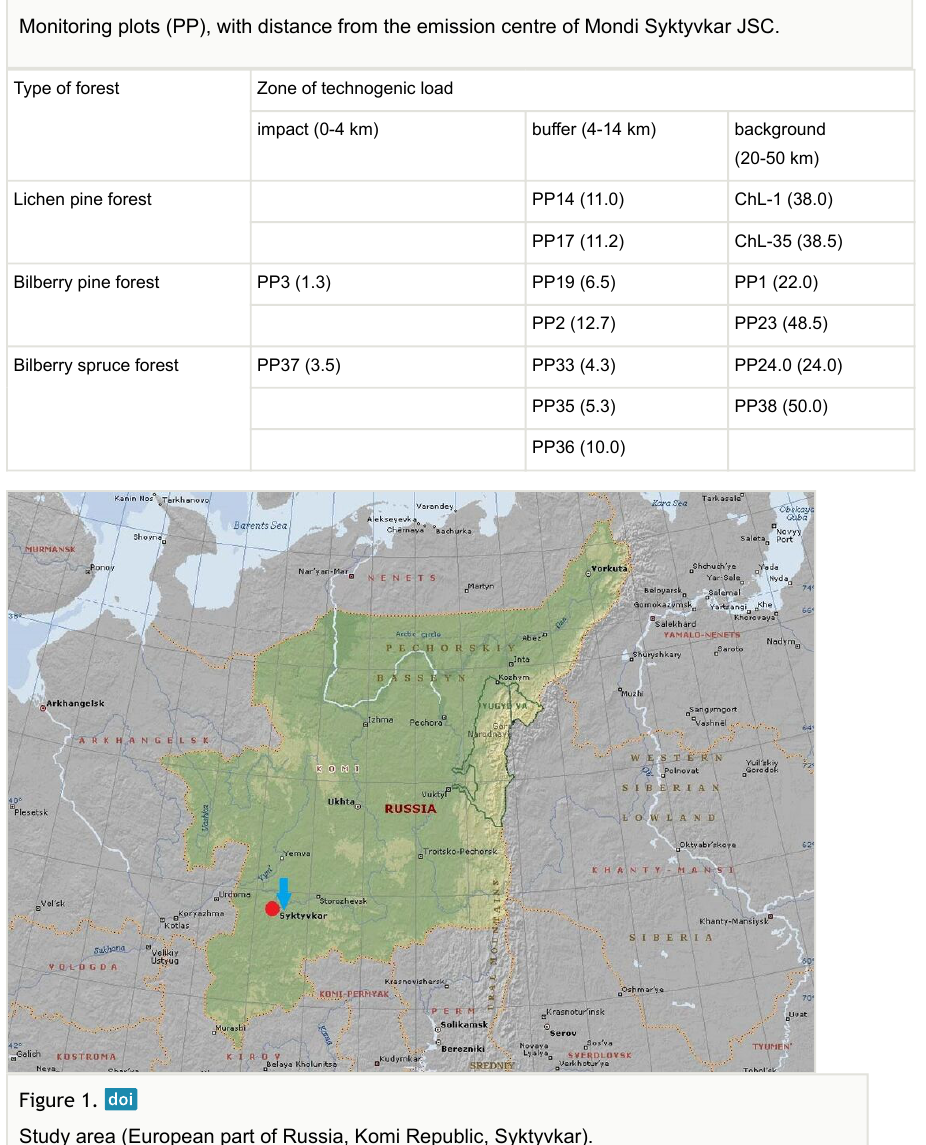
Figure 1. Study area (European part of Russia, Komi Republic,